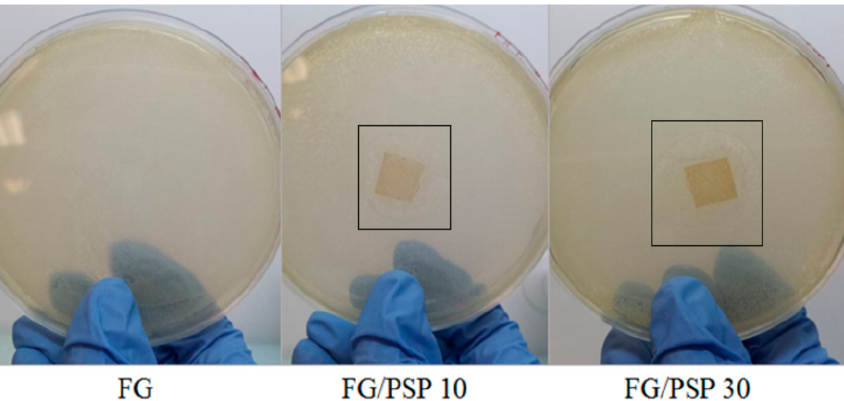
Figure 4. Pictures of the antimicrobial tests performed for all the studied formulations against S. aureus strains.